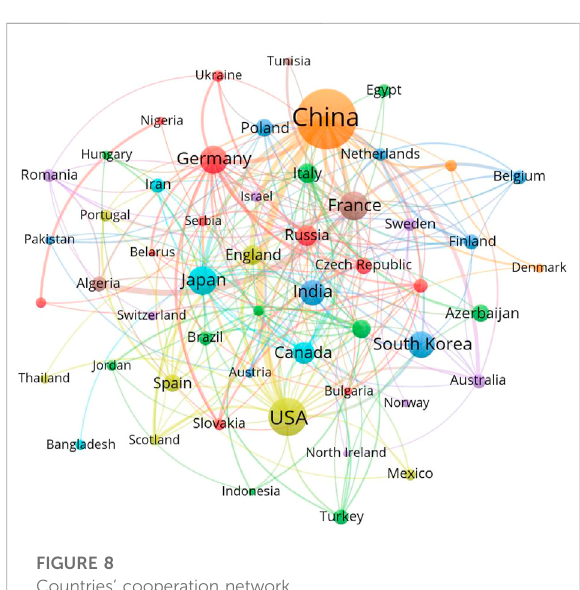
FIGURE 8 Countries ’ cooperation